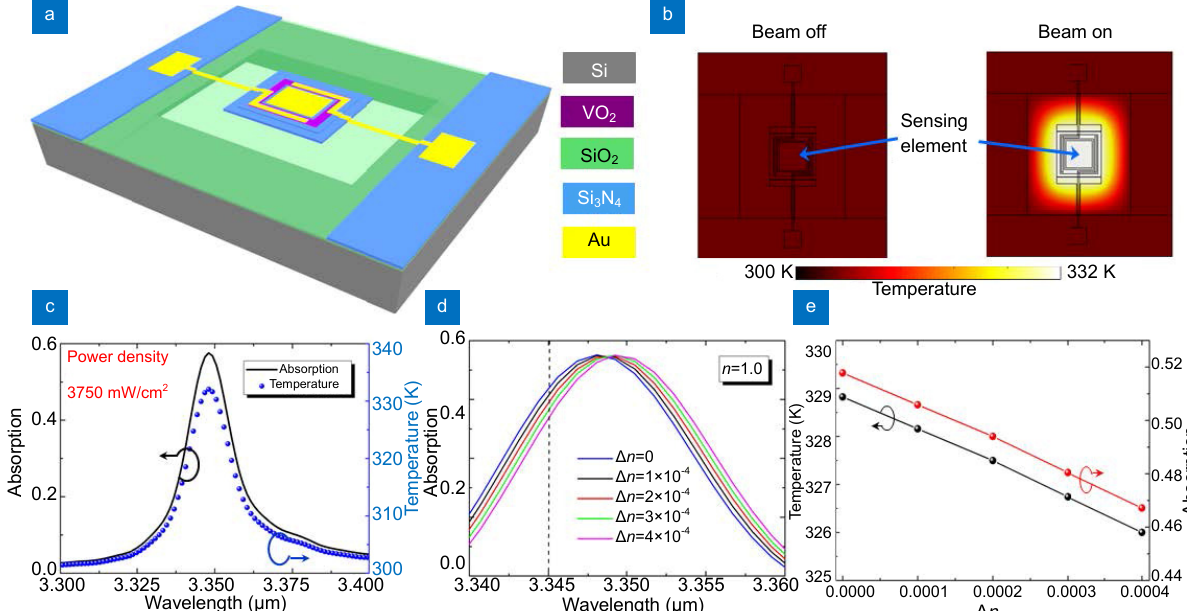
Fig. 3 | ( a ) Schematic of on-chip mid-IR gas sensor based on an SOI platform, where the silicon substrate in the area underneath the sensor is removed to reduce the thermal dissipation. The thickness of each layer in the Au/Si 3 N 4 /VO 2 /Si 3 N 4 /Si stack is 200 nm, 50 nm, 100 nm, 500 nm and 4 μ m, respectively. The thickness of the oxide layer is 1 µm. P = 3.3 µm, h g = 220 nm, w g = 3 µm. ( b ) Simulated temperature distribution across the sensor with the illumination on and off when the power density of light is 3.75 W/cm 2 at 3.348 μ m and corresponding absorption efficiency is 58%. ( c ) Temperature maximum under different wavelength illumination at the same power density and the absorption spectra of the gratings. The period number of the grating is 100. ( d ) Absorption spectra for variation of different environmental RI. ( e ) Absorption at 3.345 µm illumination and the associated device temperature versus the variation of different environmental